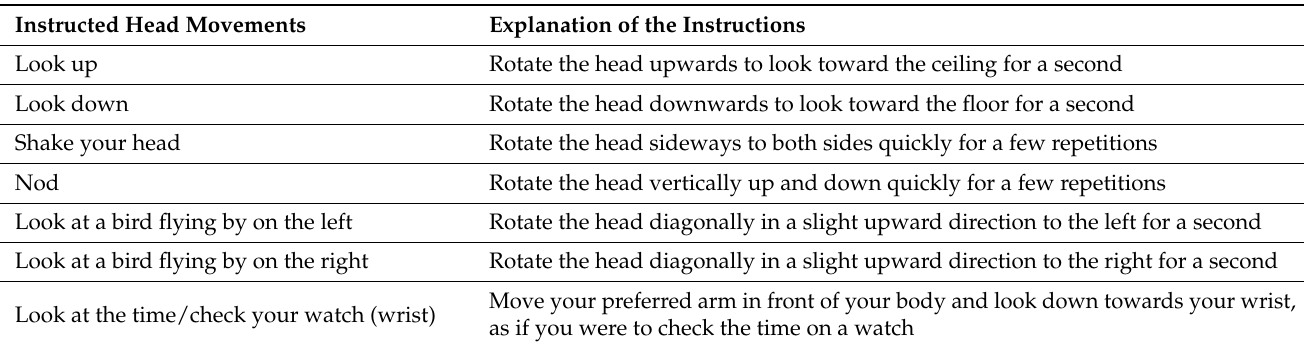
Table 1. Head-movement conditions, performed in random order in a single